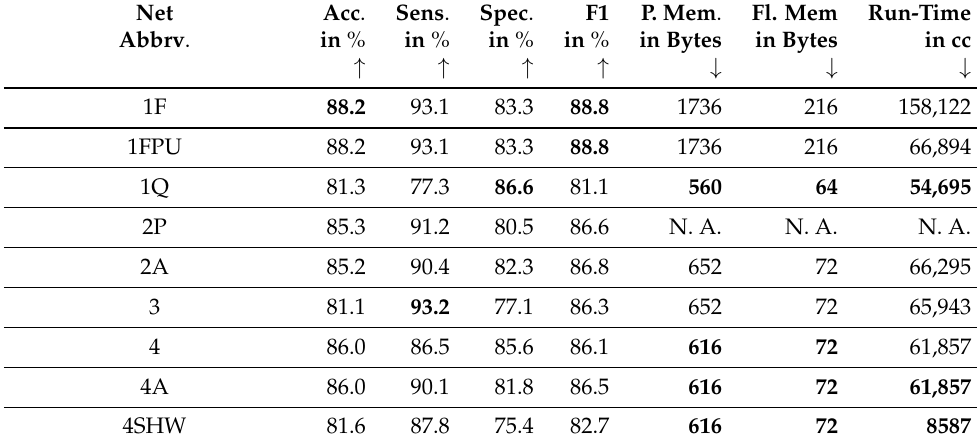
Table 2. Different MicroNet versions with their results in accuracy, sensitivity, specificity, F1-Score, parameter memory, flexible memory and run-time. Arrows indicating the goal for optimization. Net Acc . Sens . Spec